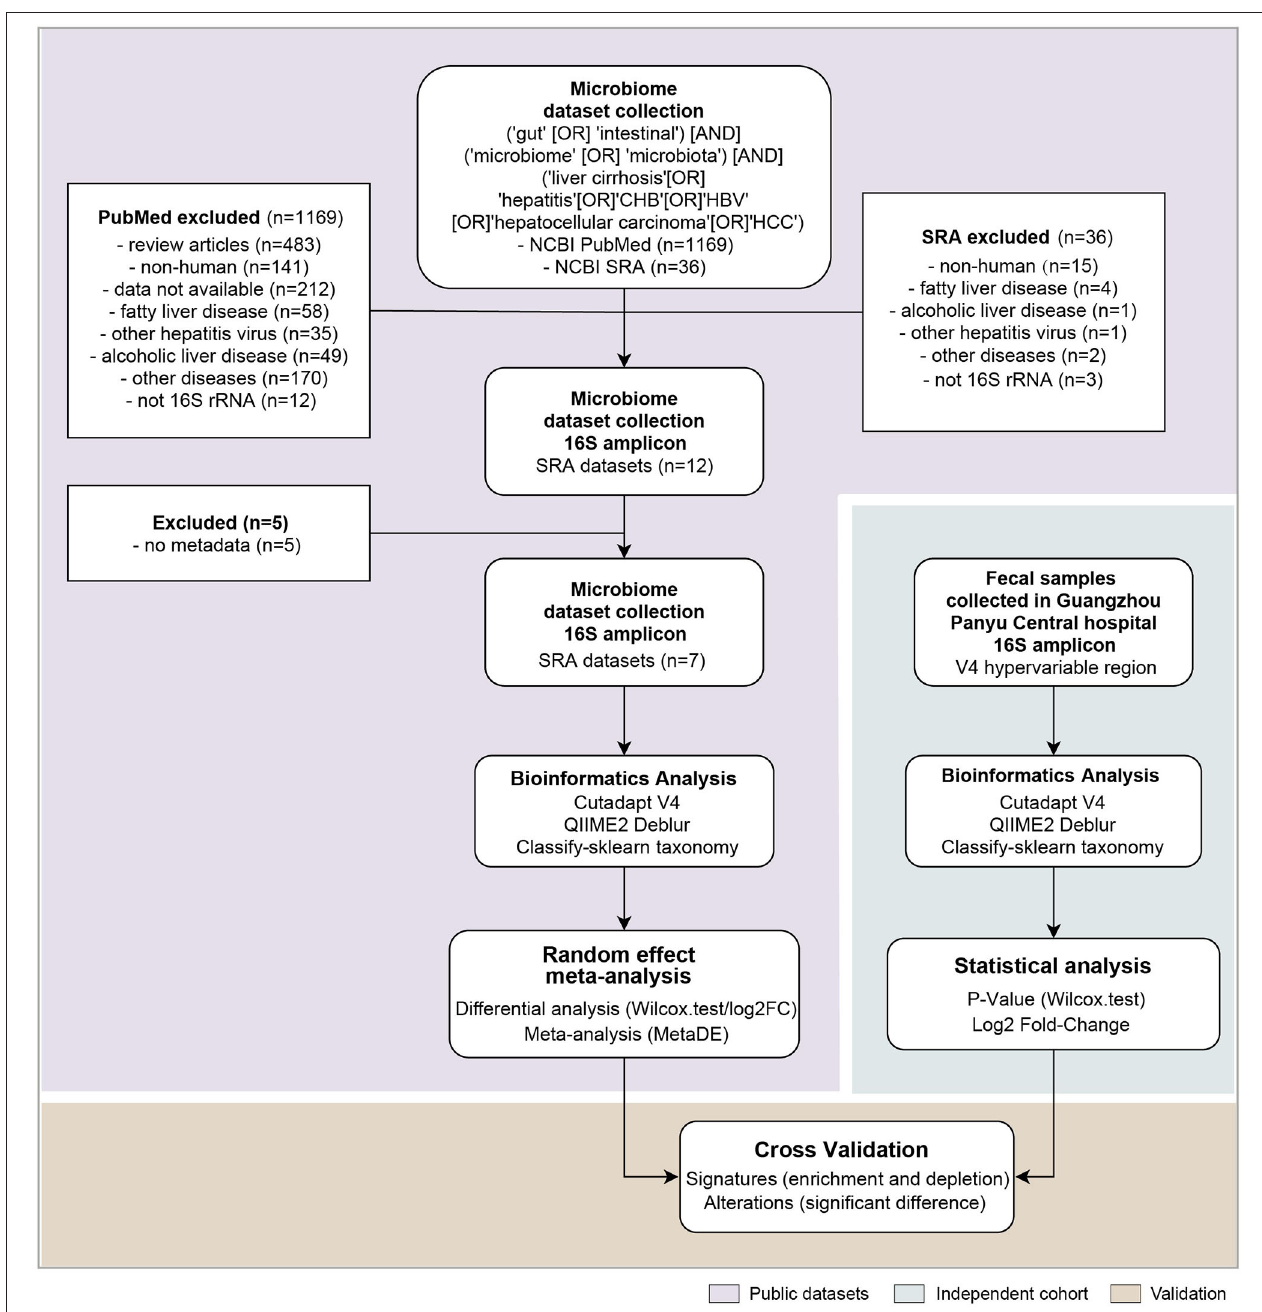
FIGURE 1 | The analysis pipeline in this study, such as the flowchart of the meta-analysis for gut microbiome of public datasets, and the independent cohort validation. Each step is shown in the white box, and the statistical methods and software used are within. n denotes the number of datasets included in each step.